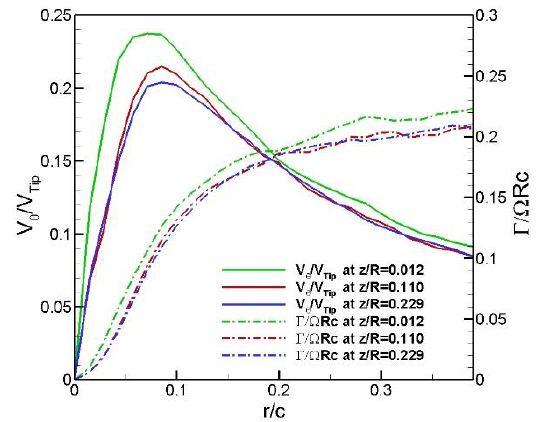
Figure 11. Normalized tangential velocity and circulation vs. r/c for each detected vortex.